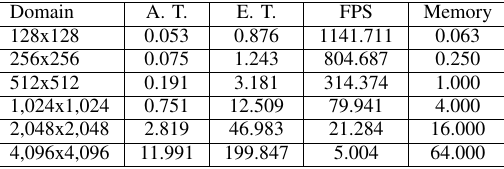
TABLE I: Physics simulation performance.